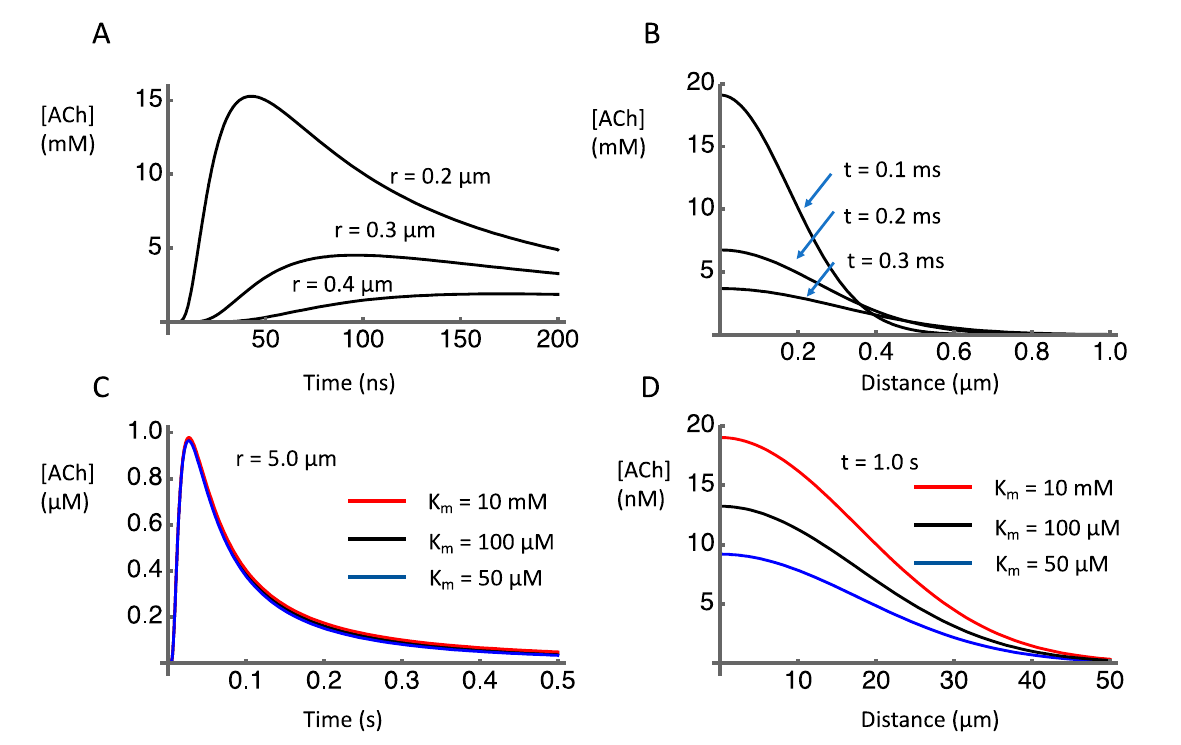
Figure 2. Simulated temporal and spatial concentration profiles after release of 1000 molecules of acetylcholine into the extracellular space. ( A ) Time course of [ACh] at indicated distances from release site. ( B ) [ACh] as a function of distance from release site at indicated time points. ( C ) Time course of [ACh] at 5 μ m distance from release site, under conditions of AChE inhibition (red line) or normal (black line) and enhanced (blue line) AChE activity. ( D ) [ACh] as a function of distance from release site 1 s after release, under conditions of AChE inhibition (red line) or normal (black line) and enhanced (blue line) AChE activity.